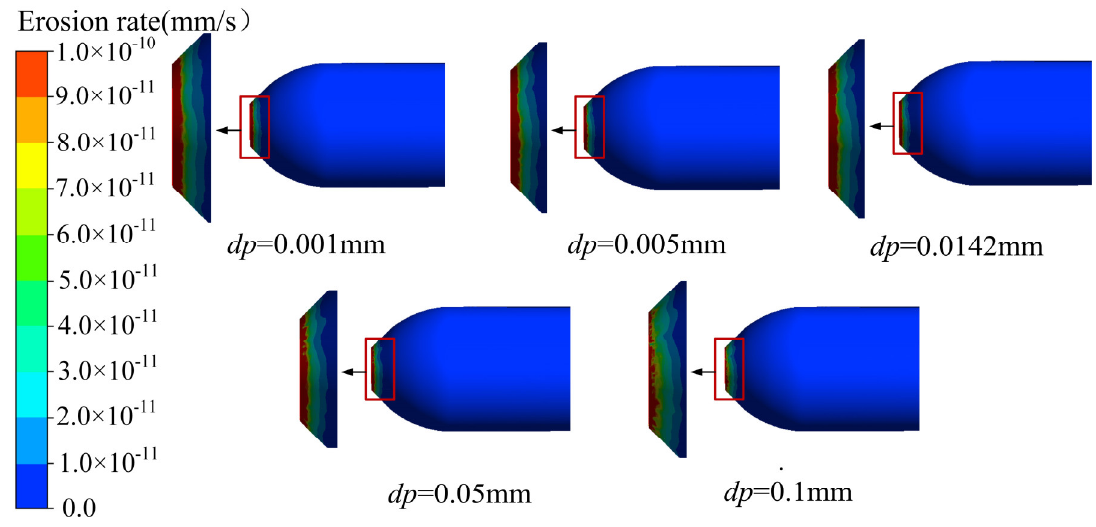
Figure 9. Erosion patterns of nozzles with different sediment particle diameters.